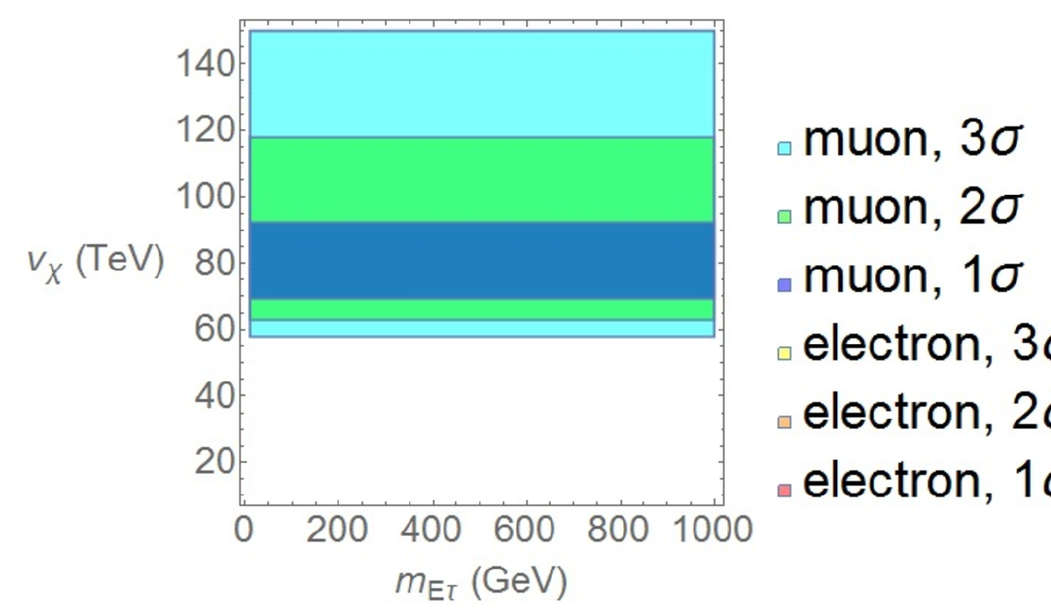
= m E = 500 GeV. e (cid:28)